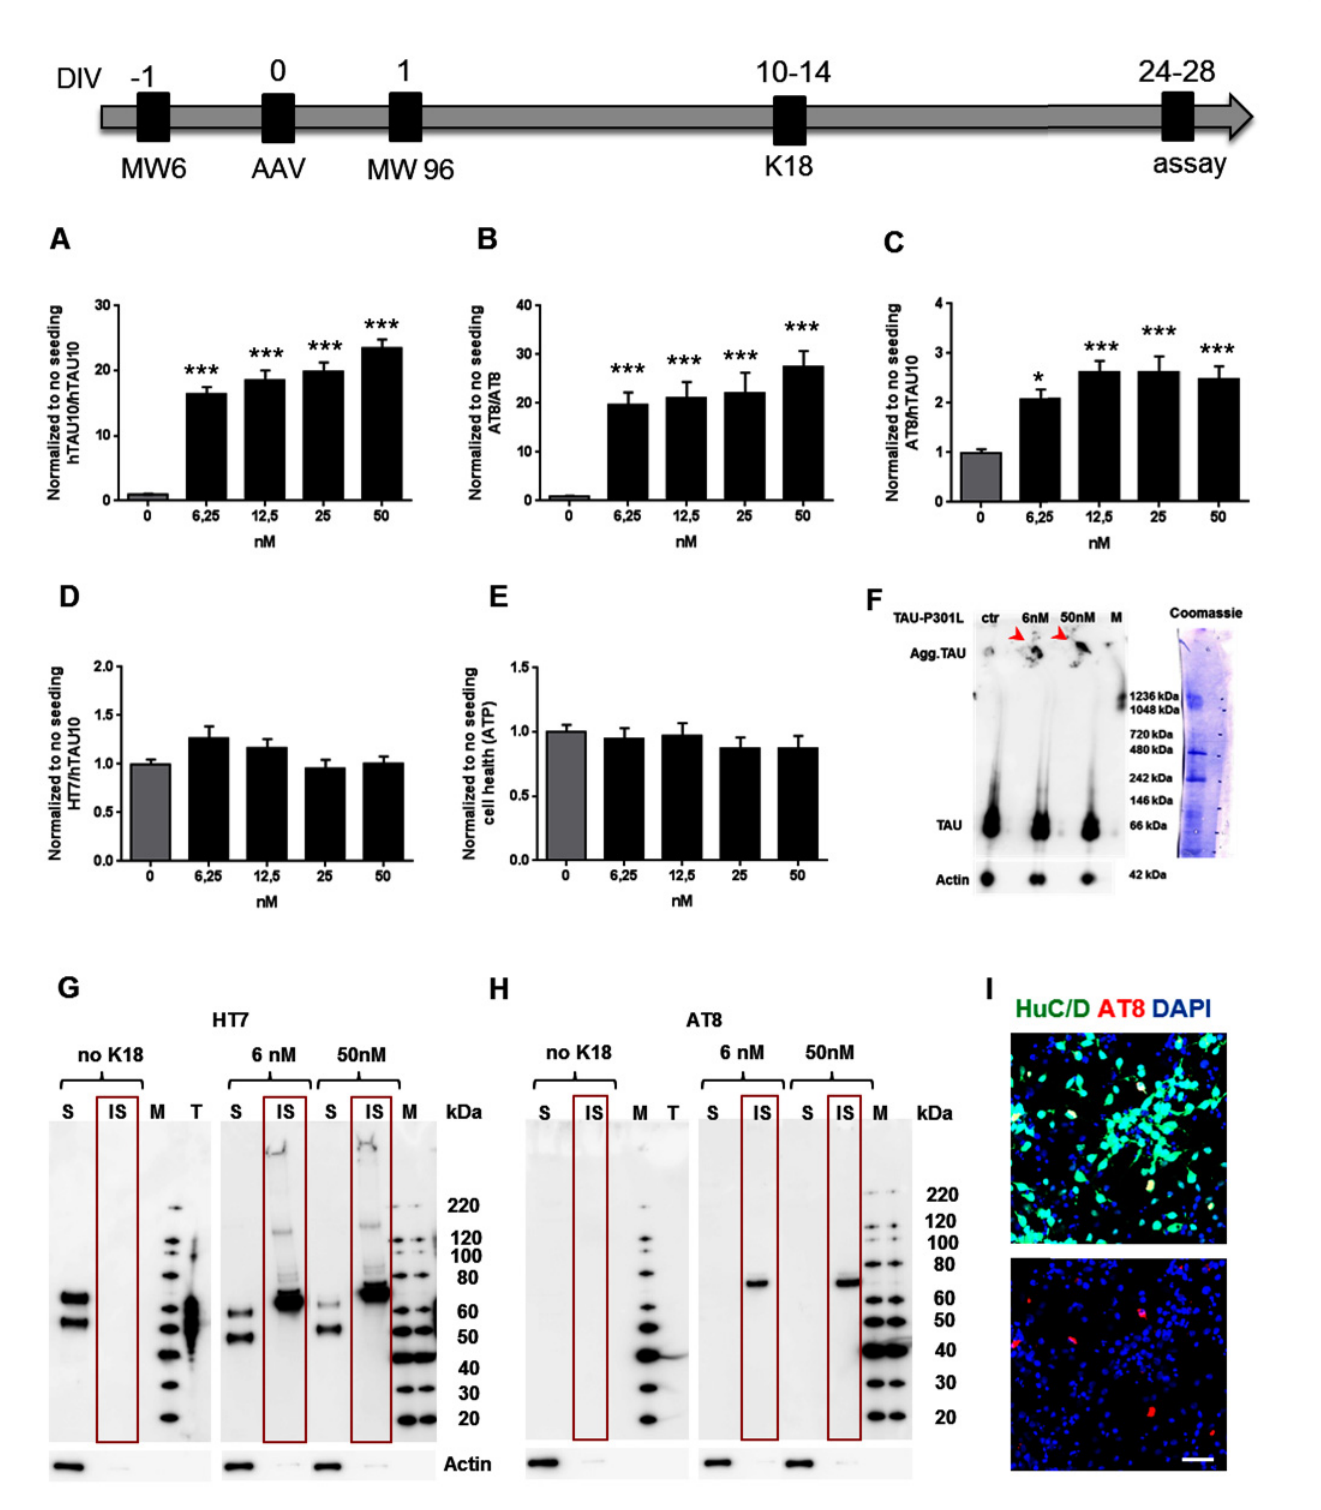
Fig 4. K18 seeding induces TAU aggregation and hyperphosphorylation in human TAU-P301L neurons. Optimal timelines are shown for AAV transduction, 96w final plating, K18 seeding and final assay. (A, B) AlphaLISA data show that K18 seeding induces an increase in both hTAU10 (P < 0,001; A)